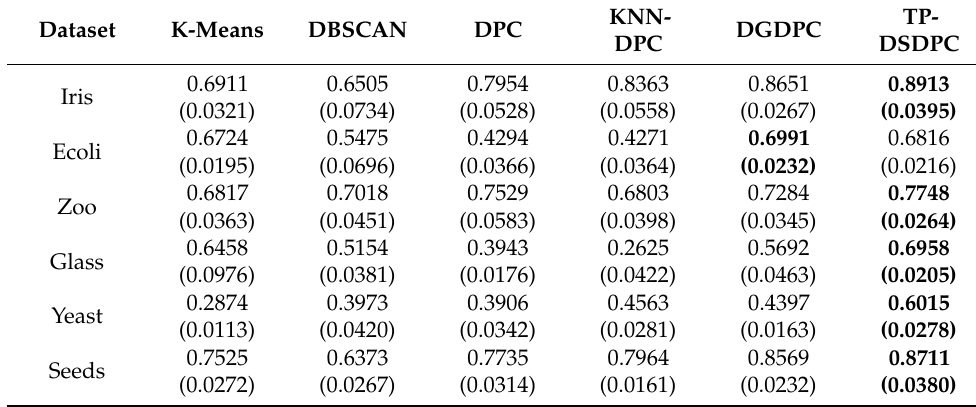
Table 8. Results of ACC on UCI datasets.